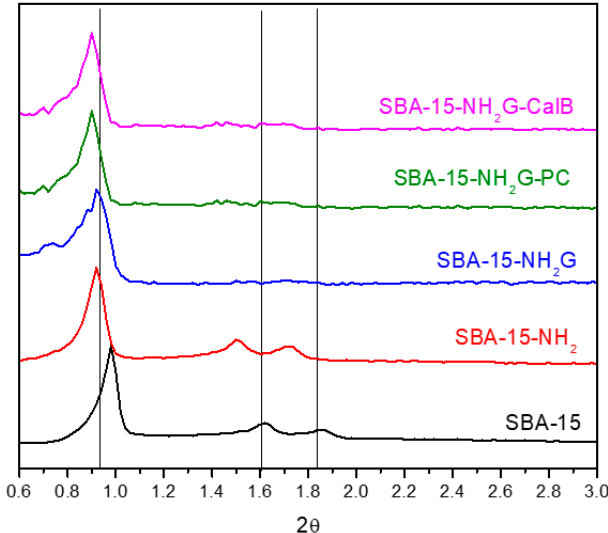
Figure 1. X-ray diffractograms of the mesoporous materials.